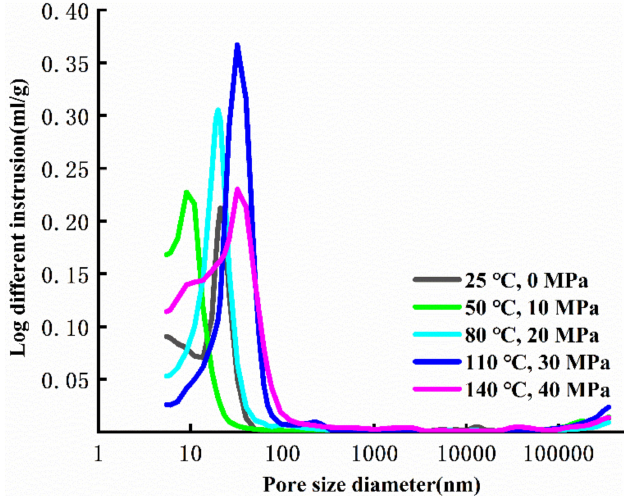
Figure 13. Pore-size distribution